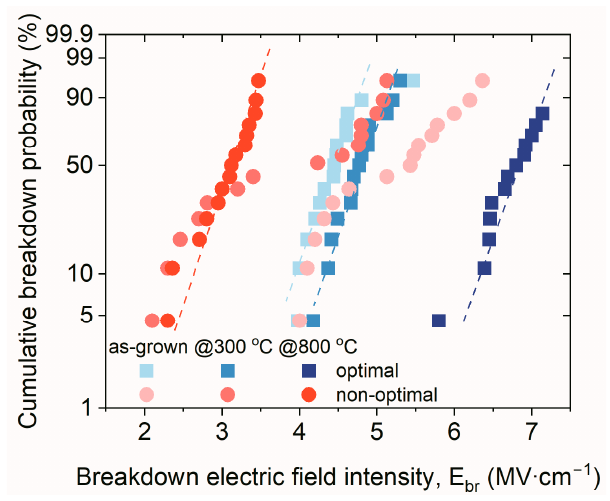
Figure 5. Cumulative breakdown statistics of MOS structures with examined hafnium oxynitride thin films, fabricated employing optimal and non-optimal HiPIMS processes; dashed lines indicate obtained trends.